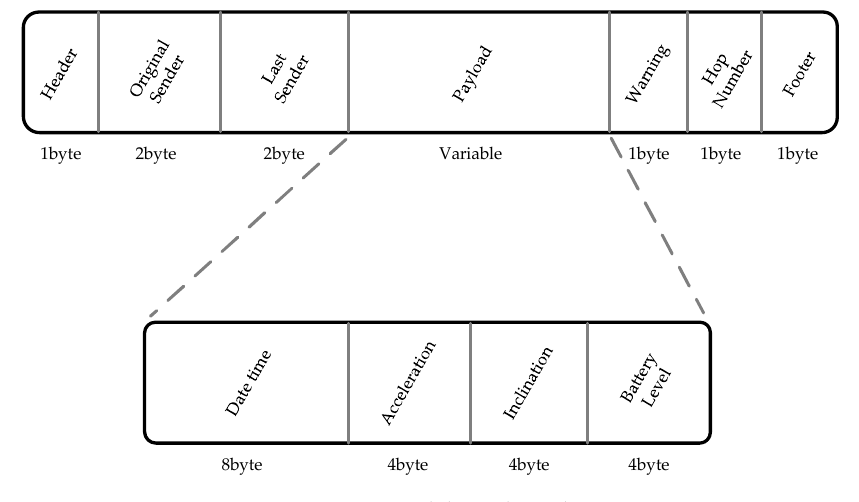
Figure 9. Network logical topology.